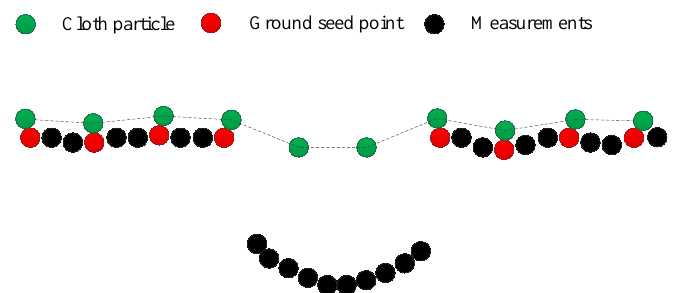
Figure 6. Extraction of ground seed points by collision detection.